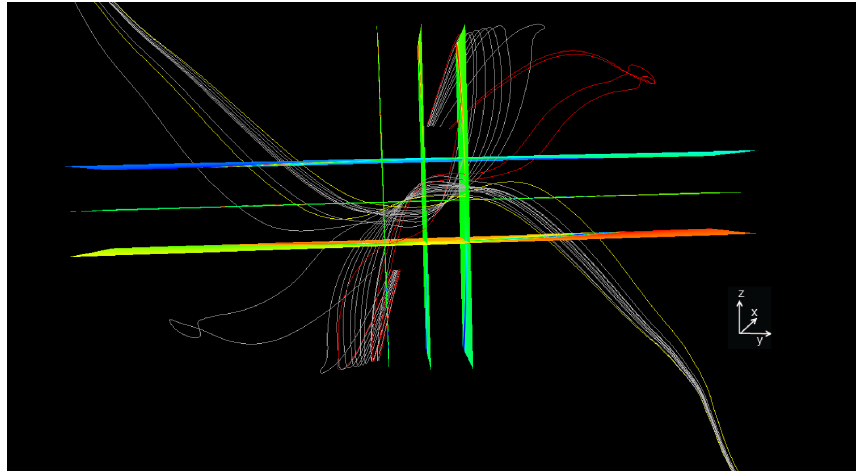
Fig. 11. Reconnected magnetic field lines drawn at t = 30s. The lines exhibit the interlinked flux tubes configuration.